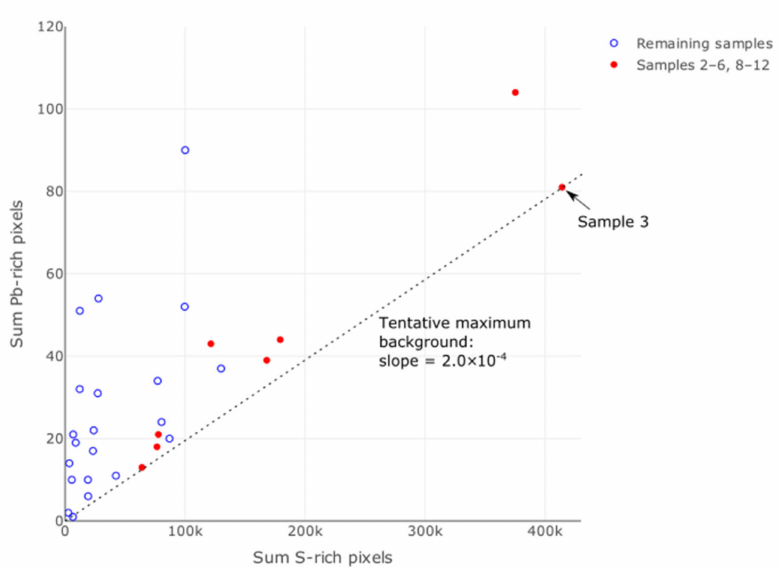
Figure 17. Pixel counts per sample (combined triplicates): Pb-rich vs sum of all S-rich pixels, for all grains containing 0-4 Pb-rich pixels (excluding those with ≥ 5 Pb-rich pixels). Sum S-rich pixels includes all PARC groups defined by presence of S peak. Samples 2–6 and 8–11 are highlighted (larger red symbols; see Section 3.3.2 (“Grains with 1–4 Pb-Rich Pixels”) for further